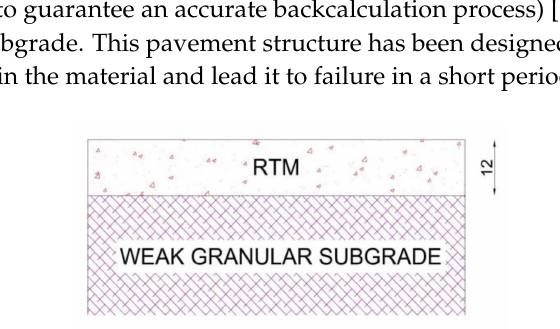
Figure 6. Second trial section pavement structure.